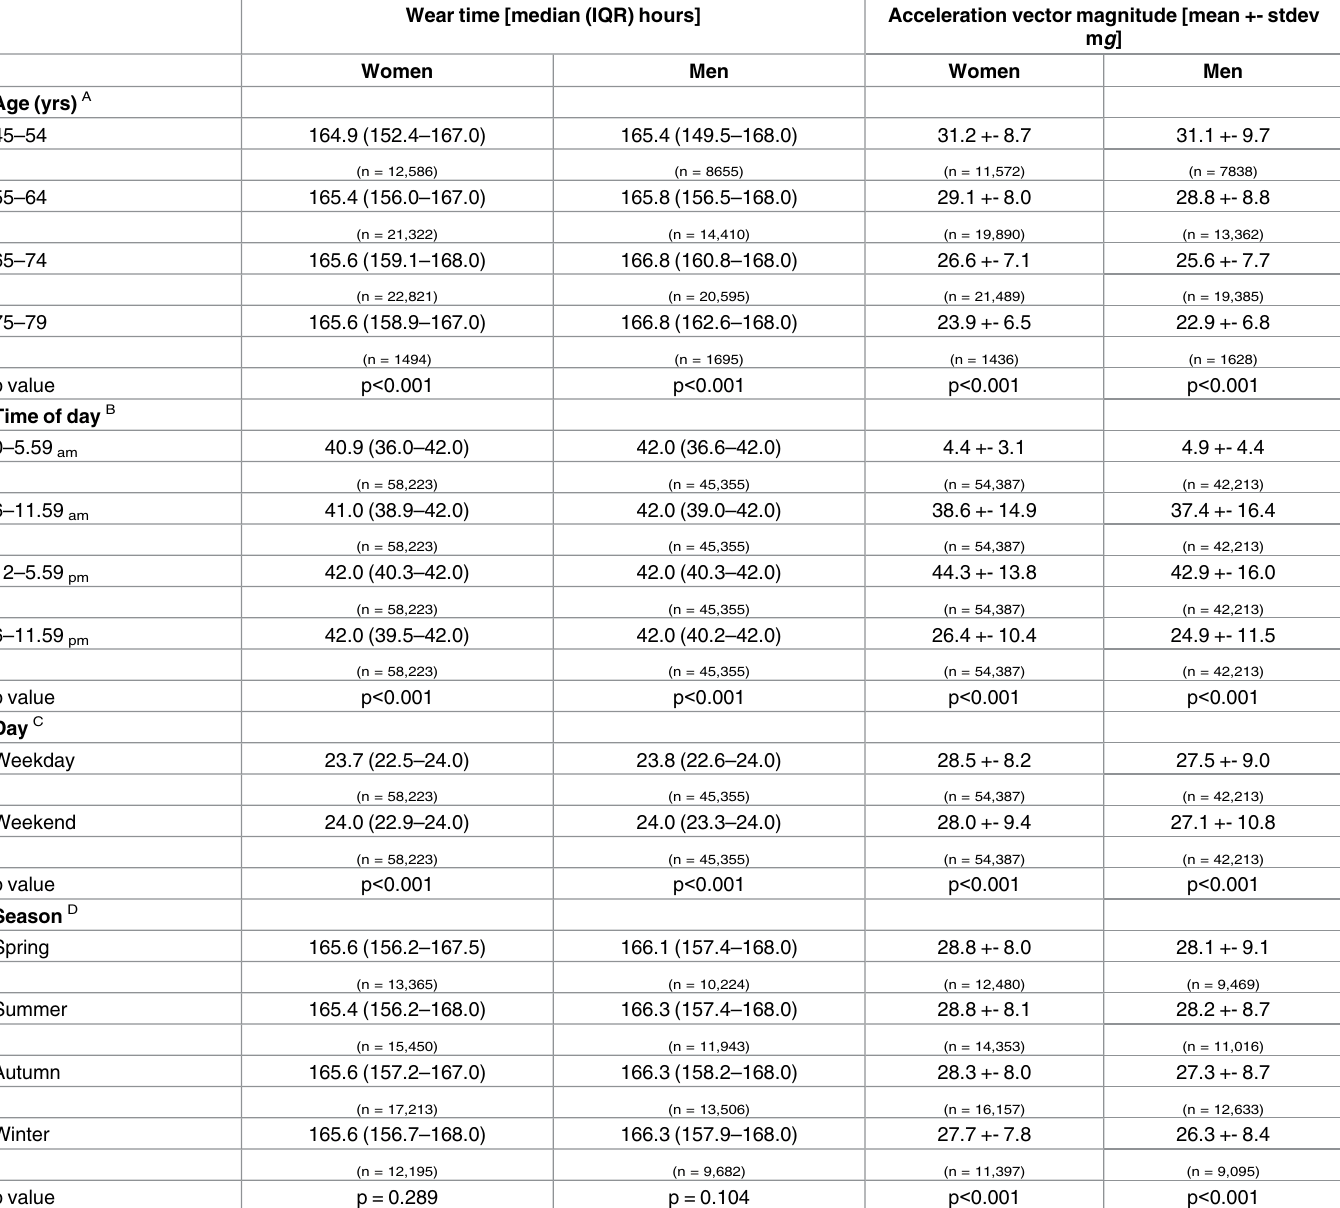
Table 1. Wear-time compliance and acceleration vector magnitude by age, day, time of day, and season, stratified by sex: The UK Biobank study 2013–2015(n =